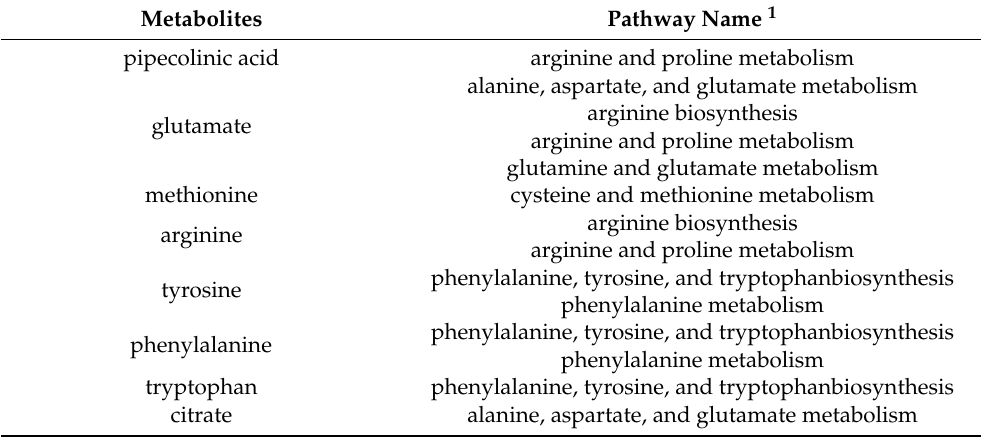
Table 4. Biological pathways associated with the metabolites included in the diagnostic model.